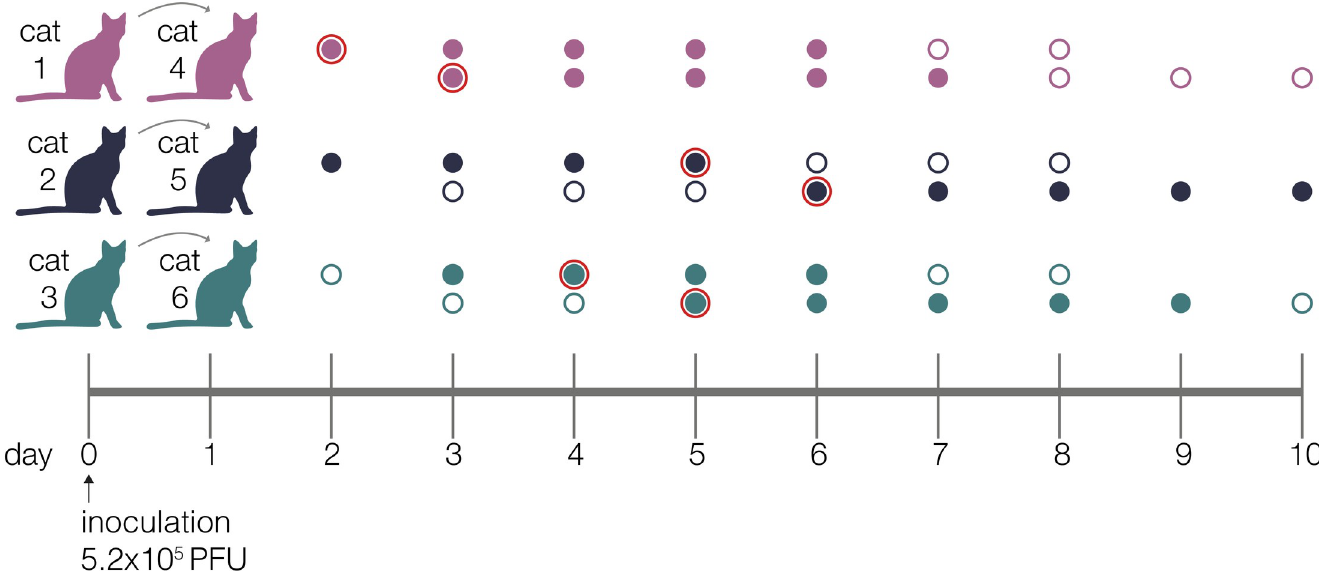
Fig 1. Experimental timeline. Schematic representing the sampling timeline for the three transmission pairs. Index cats were inoculated on day 0 with 5.2e5 PFU of a human isolate (hCoV-19/Japan/UT-NCGM02/2020) and were co-housed with a naive cat starting on day 1. Within each transmission pair, the top row of circles represents the index cat and the bottom row represents the contact cat. Open circles represent days on which there was no detectable infectious virus as indicated by plaque assay, and closed circles highlight days when live virus was recovered. Circles with a red outline indicate timepoints which were used in the beta-binomial estimate to calculate transmission bottleneck